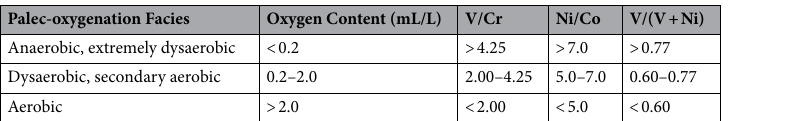
Palec-oxygenation